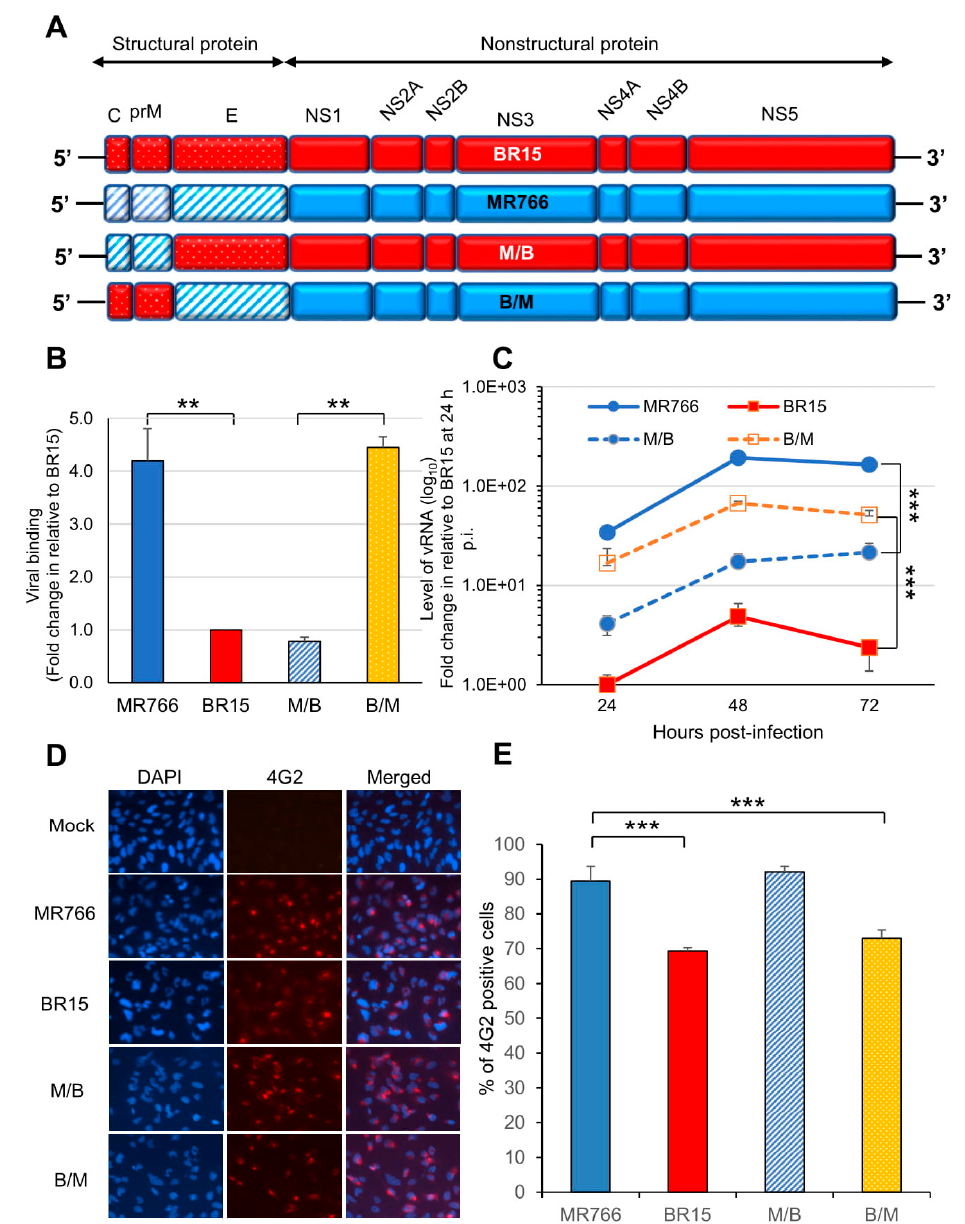
Figure 3. Correlation of the ZIKV C-prM with viral attachment and viral infection. ( A ) Generation of chimeric ZIKV molecular clones are shown along with their parental clones. The chimeric viruses were made between the MR766 and the BR15 ZIKV molecular clones. The viral genome exchange is at the junction of prM and E protein. ( B ) Viral binding was measured by presence of cell-associated vRNA 1 h p.i. A housekeeping gene GAPDH was used as an endogenous control for the measurement of viral bindings. Results represent average and standard deviation (X ± SD) of four independent experiments. ( C ) ZIKV viral replication was measured by RT-qPCR with timeframe as indicated. ( D ) Viral infection was measured by anti-E mAb 4G2 at 48 h p.i. ( E ) Quantification of the results shown in ( D ). SNB-19 cells were infected with Zika viruses with MOI of 1.0. Three different experiments were carried out in triplicates. Average cell number counted was about 100–200. All quantitative results represent average and standard deviation (X ± SD). Levels of statistical significance were calculated by two-tailed and paired t-test for ( B ), and Two-way ANOVA was used for ( C ). **, p < 0.05; ***, p < 0.01.